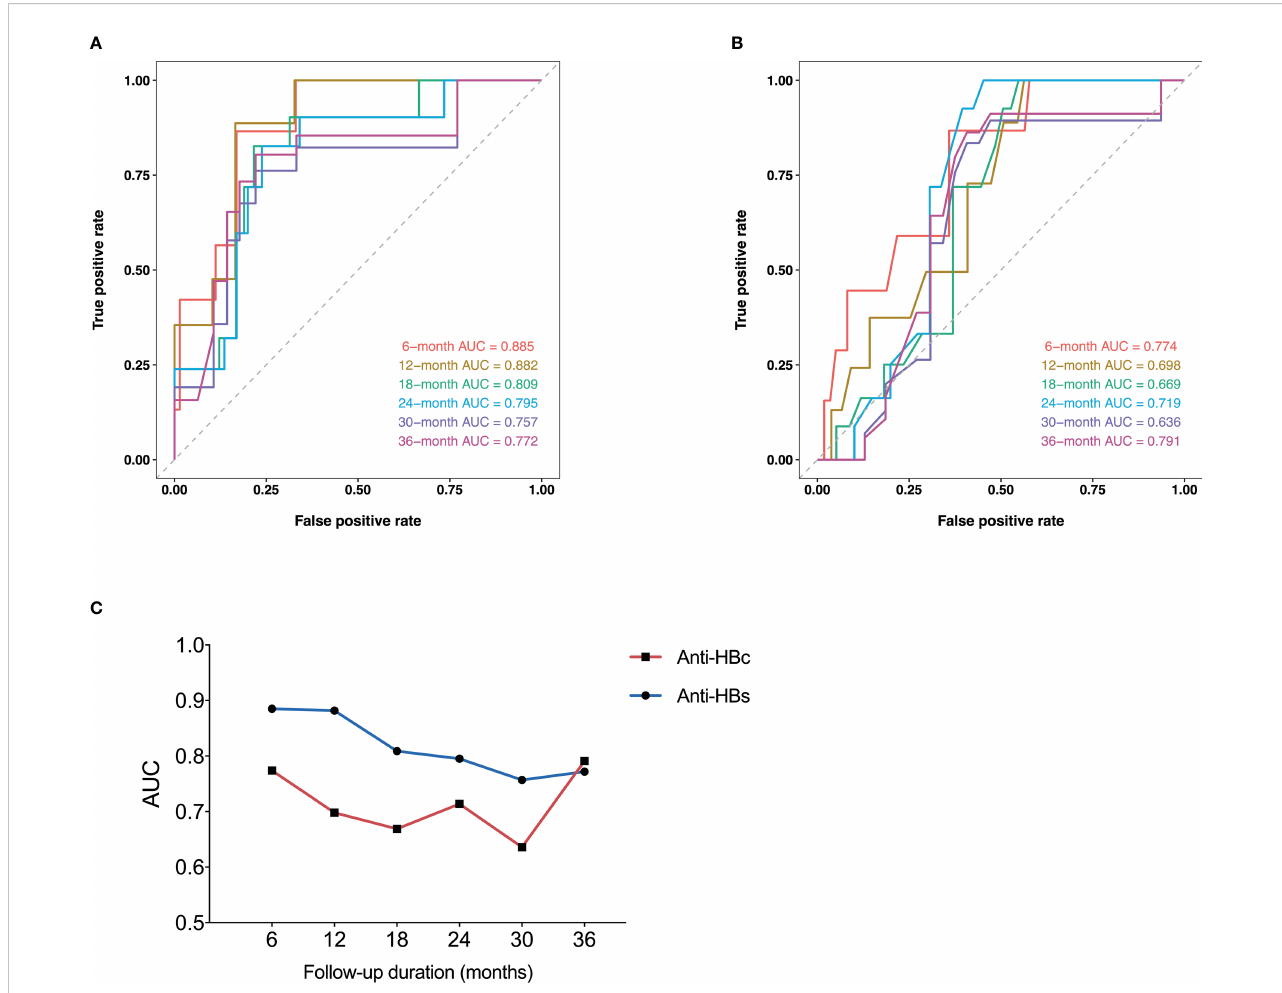
FIGURE 3 Time-dependent ROC curves of anti-HBs (A) and anti-HBc (B) at EOT for HRV incidence at 6, 12, 18, 24, 30, and 36 months after the start of follow-up. Plots of AUCs of anti-HBs and anti-HBc at the same time point as above (C) . ROC, receiver operating characteristic curve; Anti-HBs, hepatitis B surface antibody; Anti-HBc, hepatitis B core antibody; HRV, HBsAg reversion; AUC, area under the receiver operating characteristic curve; EOT, end of PEG-IFN treatment.